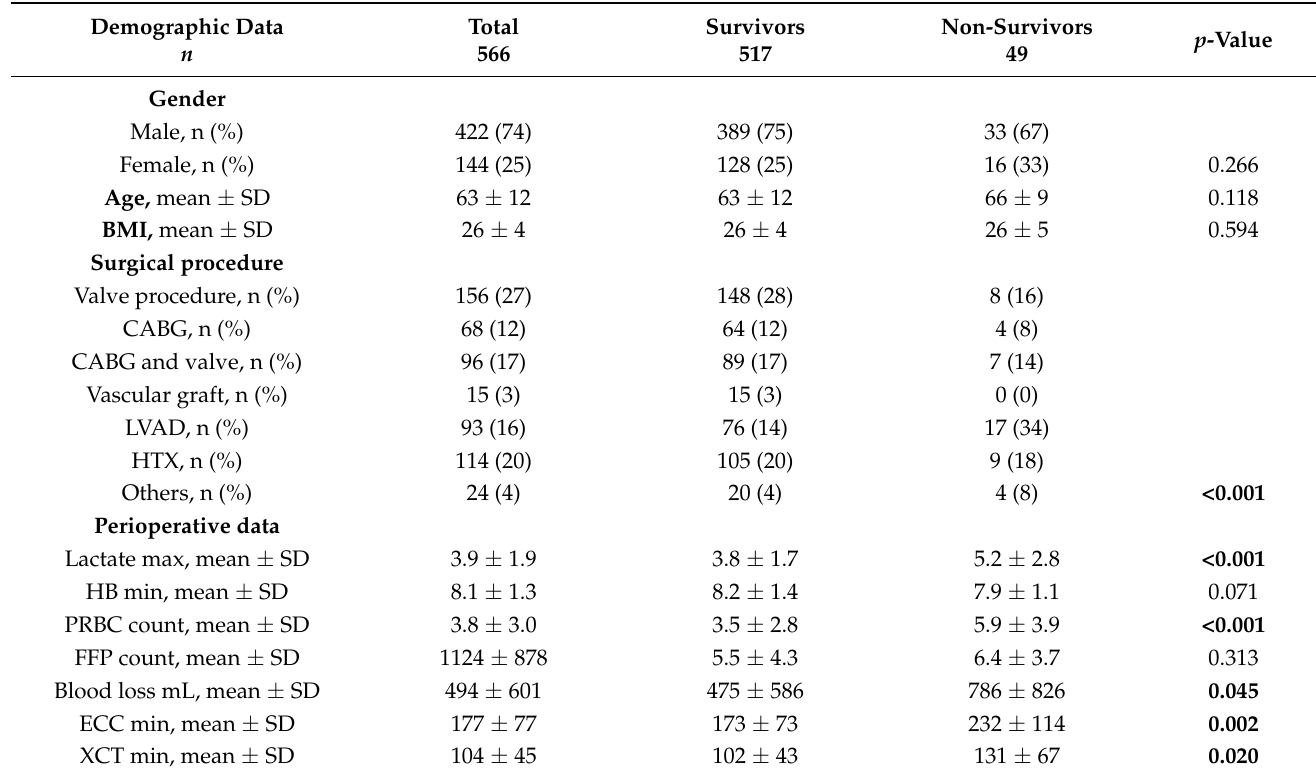
Table 2. Demographic and clinical